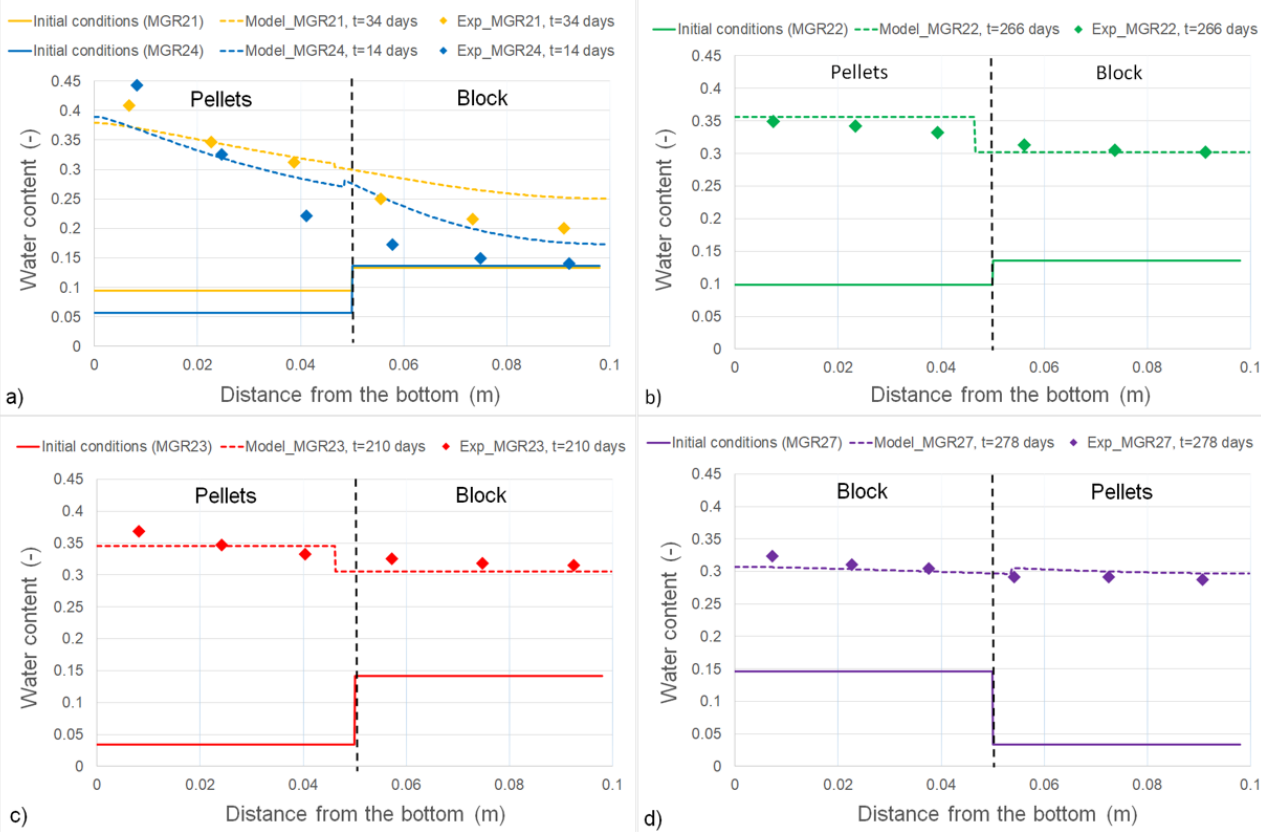
Figure 7. Comparison of modeling results (dashed lines) and measurements (experimental points) of water content distribution along the height of the samples ( a ) MGR21 and MGR24 after 34 and 14 days, respectively; ( b ) MGR22 after 266 days; ( c ) MGR23 after 210 days; ( d ) MGR27 after 278 days.